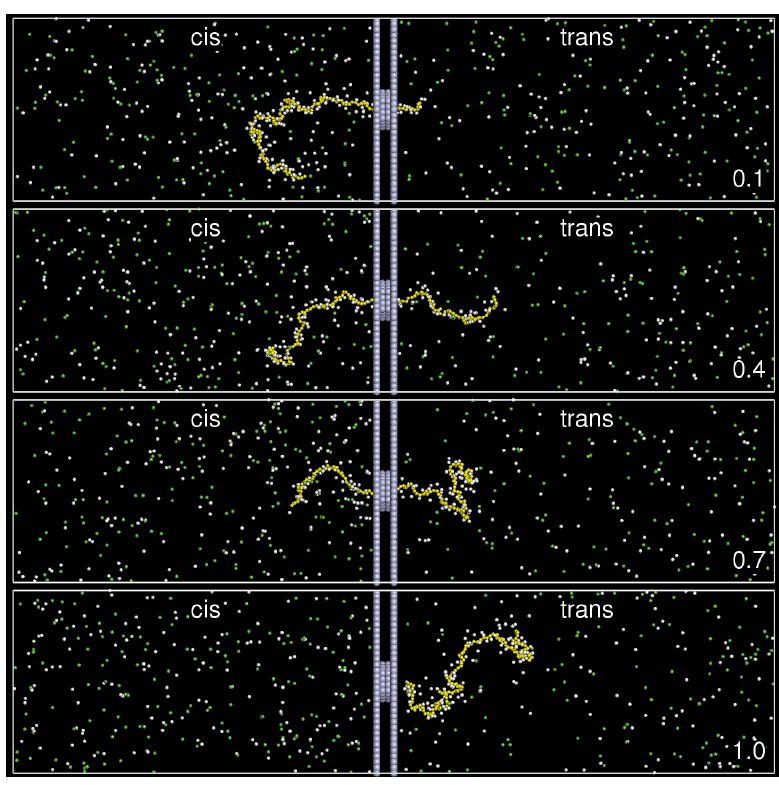
Figure 2. Snapshots of a typical translocation run for N = 128 in E = 0.5 at time t = 0.1 τ , 0.4 τ , 0.7 τ , and 1.0 τ . The color scheme is the same as described in Figure